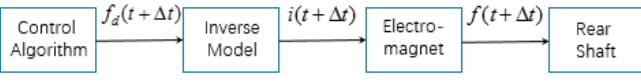
Figure 7. Open-loop compensation of electromagnetic hysteresis.